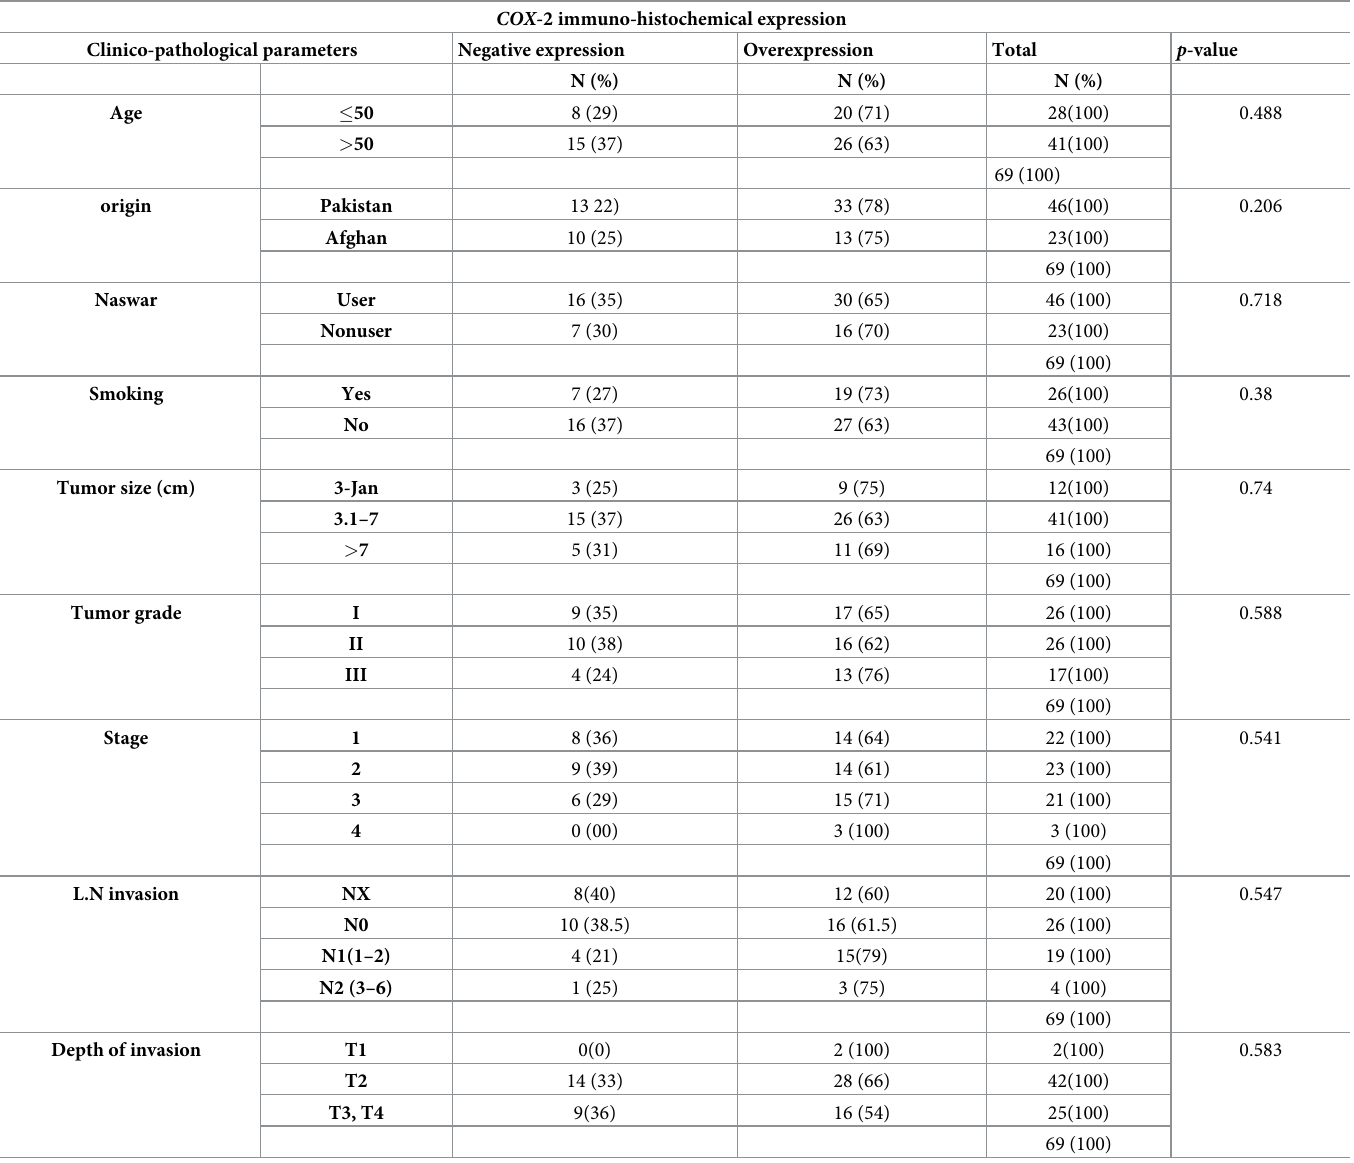
Table 4. Correlation of COX immuno-histochemical expression with clinico-pathological parameters. COX -2 immuno-histochemical expression Clinico-pathological parameters